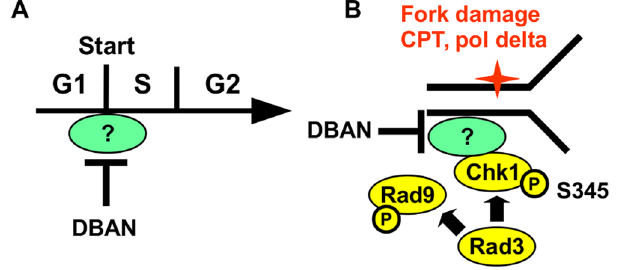
Figure 6. ( A ) DBAN blocks G1-S transition. ( B ) DBAN prevents Chk1 phosphorylation by Rad3 at a broken fork. The details of the model are discussed in the main